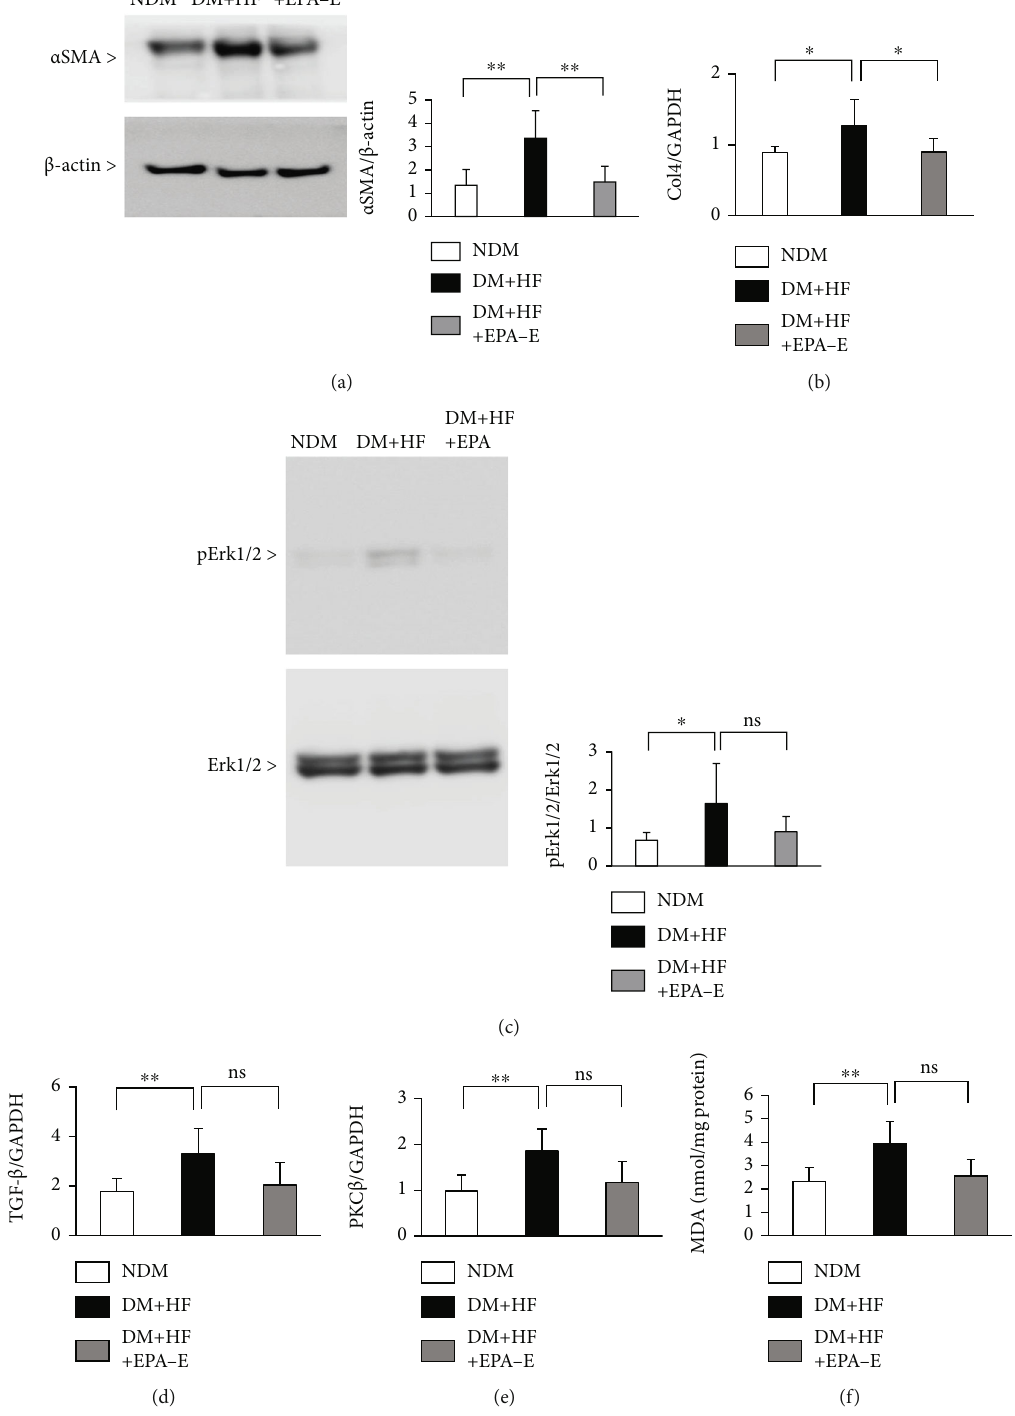
Figure 2: E ff ect of EPA-E on TGF- β , PKC β , and extracellular matrix in the experimental groups. (a) Immunoblot analysis of α SMA in the renal cortex of the nondiabetic mice, STZ-induced diabetic mice, and STZ-induced diabetic mice treated with EPA-E. (b) Type 4 collagen mRNA expression in the renal cortex of the experimental groups. (c) Immunoblot analysis of phosphor-Erk1/2 in the renal cortex of the experimental groups. (d) and (e) TGF- β (d) and PKC β (e) mRNA expression in the renal cortex of the experimental groups. (f) Malondialdehyde is measured by the thiobarbituric acid reactive substance assay. ∗ P < 0 : 05 . ∗∗ P < 0 : 01 . ns: not signi fi cant. These data are expressed as means ± SD . NDM: nondiabetic mice; DM + HF : mice with STZ-induced diabetes were fed a high-fat diet; DM + HF + EPA − E : STZ-induced diabetic mice were fed a high-fat diet treated with EPA-E. Regarding immunoblot, membranes are cut prior to hybridization with antibodies, so these are not images of full-length